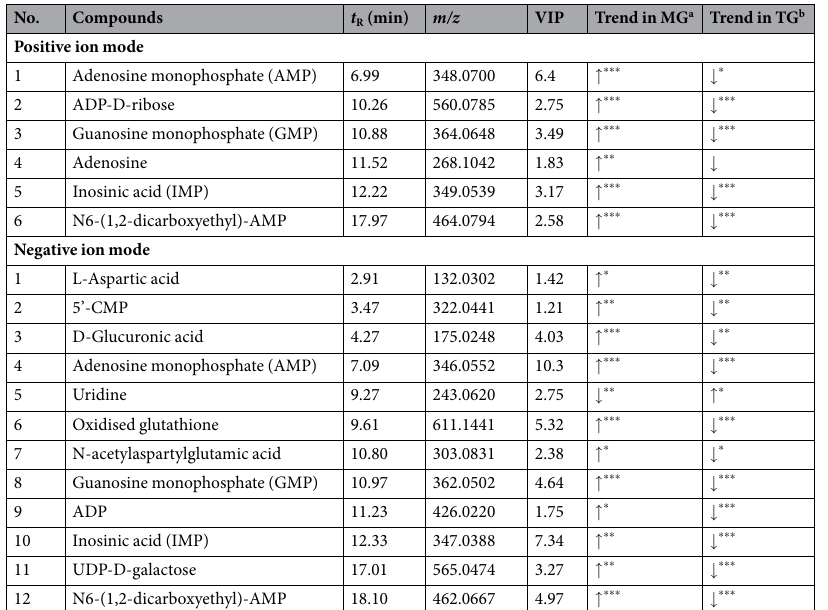
Table 2. Metabolites selected as biomarkers characterized in hypothalamus profiles and their change trends. The levels of potential biomarkers were labeled with ( ↓ ) downregulated and ( ↑ ) upregulated ( * P < 0.05; ** P < 0.01; *** P < 0.001; one-way ANOVA followed by independent samples t -test). a Change trend compared with CG. b Change trend compared with